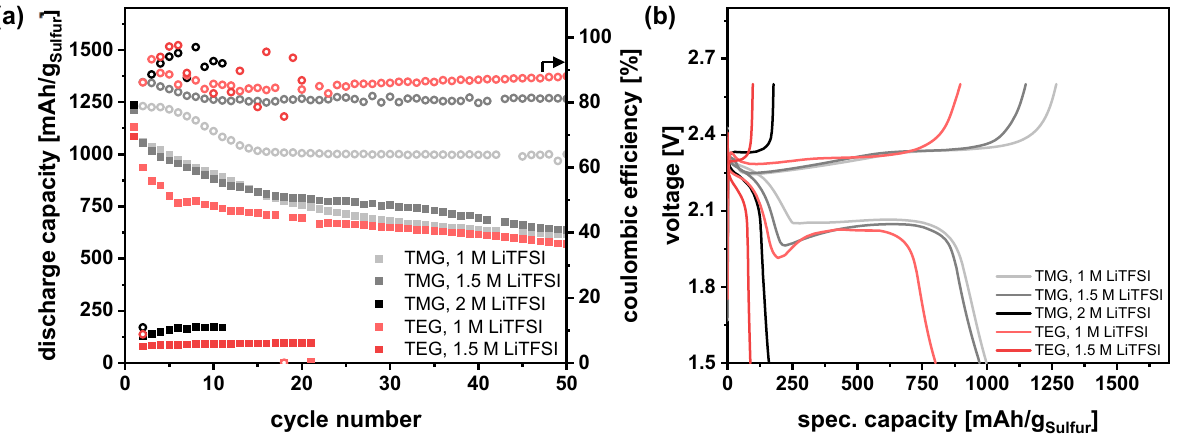
Figure 2. Galvanostatic cycling at 0.1 C and 40 °C with pure TMG/TEG-electrolyte with varying LiTFSI-concentration: ( a ) cycle life, ( b ) voltage profiles in coin cells.